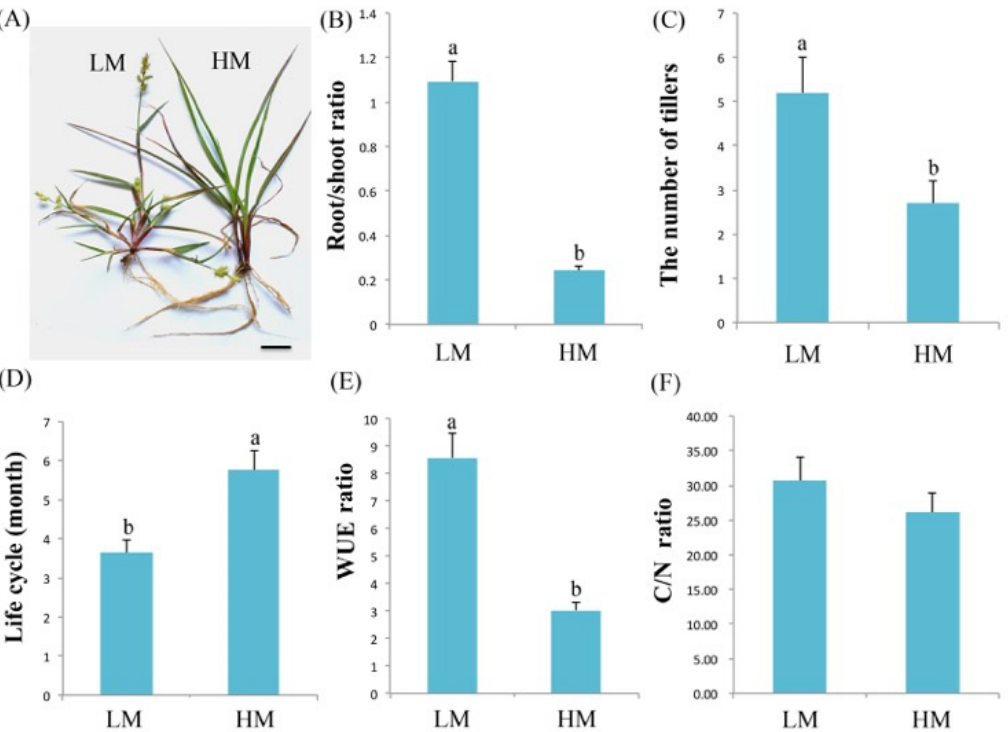
Figure 1. Morphological and physiological characteristics of C. spinifex grown under severe drought or normal conditions. ( A ) Morphology of C. spinifex plants grown under severe drought (G2, 5% soil moisture) and normal (G0, 20% soil moisture) conditions. ( B ) Comparison of root/shoot ratio. ( C ) Comparison of the number of tillers. ( D ) Comparison of the whole life cycle from germination to seed harvesting. ( E ) Comparison of water use efficiency (WUE). ( F ) Comparison of carbon to nitrogen (C/N) ratio. Different superscript letters indicate statistically significant ( p < 0.05) differences between G0 and G2 conditions based on the Student’s t ‐ test. Differences and standard deviations (error bars) were calculated from the results of three biological replicates. Scale bar = 1 cm.